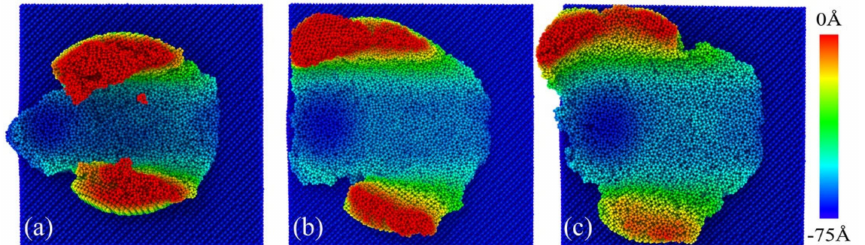
Figure 12. An indenter of various sizes of plows; the top view image of the rough GaAs. The indenter size was ( a ) 9 nm, ( b ) 12 nm and ( c ) 14 nm, respectively. The height of the rough peak of GaAs was 7 nm and the plowing depth was 7 nm. Atoms were colored by heights in z-direction.